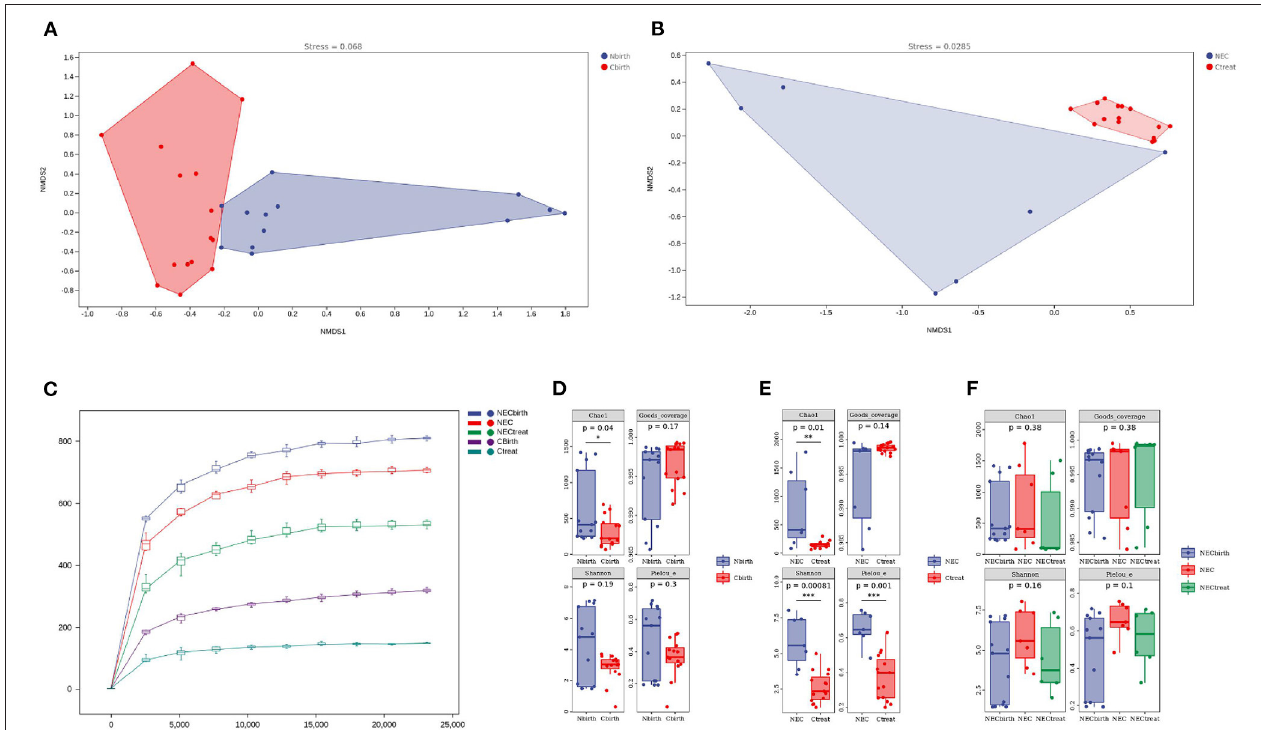
FIGURE 2 | Alpha and beta diversity analysis. (A,B) Beta diversity analysis: (A) at birth, (B) at necrotizing enterocolitis diagnosis. (C) Rarefaction curve. (D–F) Alpha diversity analysis. Chao 1 index is used to estimate the actual number of species in the community. Shannon diversity index comprehensively considered the richness and evenness of the community. Pielou’s_e assesses the coverage of species in the